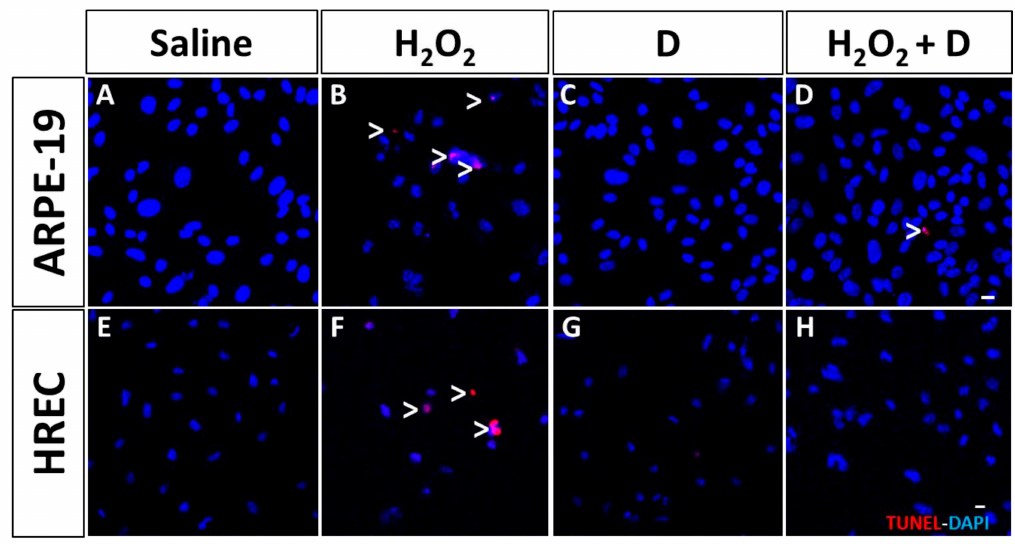
Figure 5. Late apoptosis measured in ARPE-19 ( A – D ) and HREC ( E – H ) cells by TDT- mediated